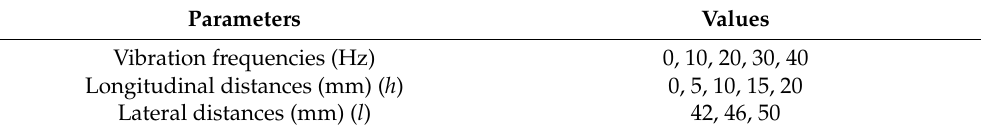
Table 2. Factors and levels of bench test.